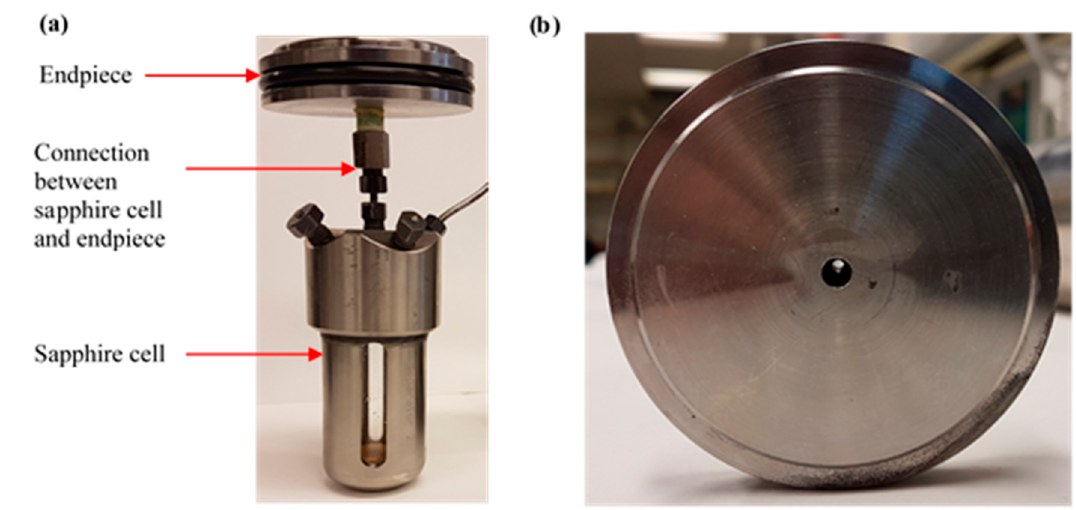
Figure 4. ( a ) Sapphire cell with the end piece; ( b ) end piece view from inside.